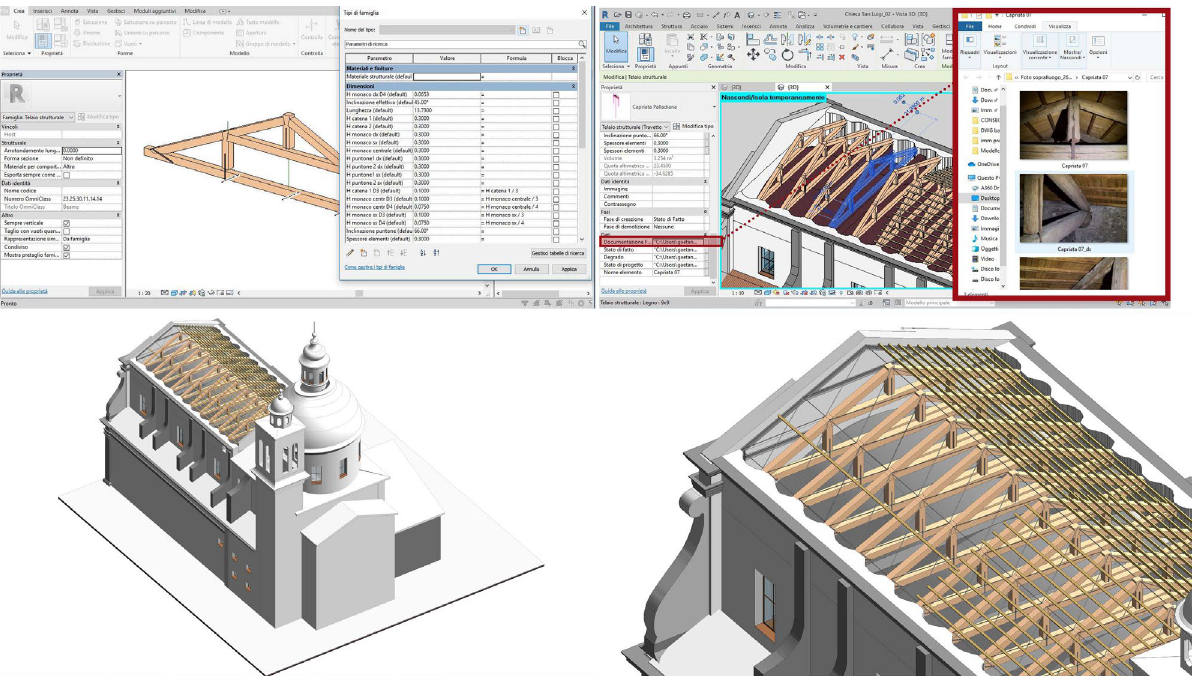
Figure 2: structural intervention on the roof of the Basilica of San Luigi in Castiglione delle Stiviere. The scheme of the single truss (top, left), the model of the roof with all the trusses and the linked photos (top, right), the entire model (bottom, left) and the detail of the structural project for the roof (bottom,